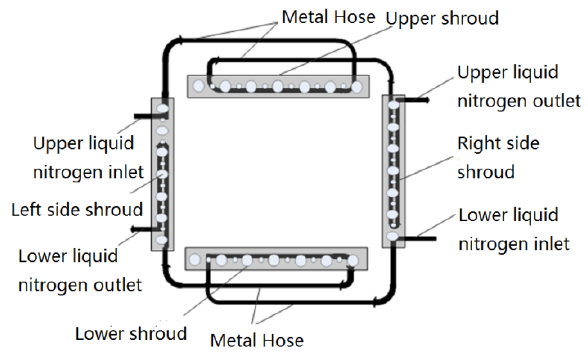
Figure 3. Liquid nitrogen line layout.